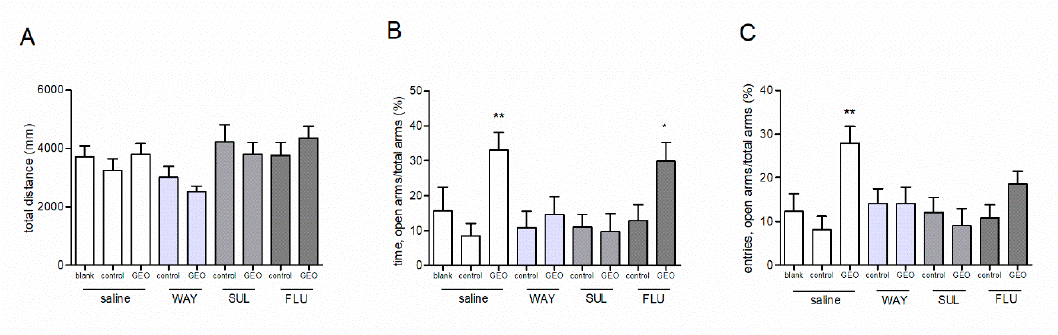
Figure 4. Effects of pretreatment of WAY100635, sulpiride and flumazenil on the anxiolytic effect of GEO (0.2 mg/L) in OF and EPM tests. ( A ) The total distance of the mice explored in the OF test. ( B ) The time the mice spent in open arms in EPM tests. ( C ) The entries of the mice into the open arms in EPM tests. WAY: WAY100635 (0.3 mg/kg), SUL: Sulpiride (40 mg/kg), FLU: Flumazenil (5 mg/kg). Values represent the mean ± SE ( n = 8), * p < 0.05 vs. saline + control group, ** p < 0.01 vs. saline + control group. One-way ANOVA followed by a post hoc Duncan test was used.